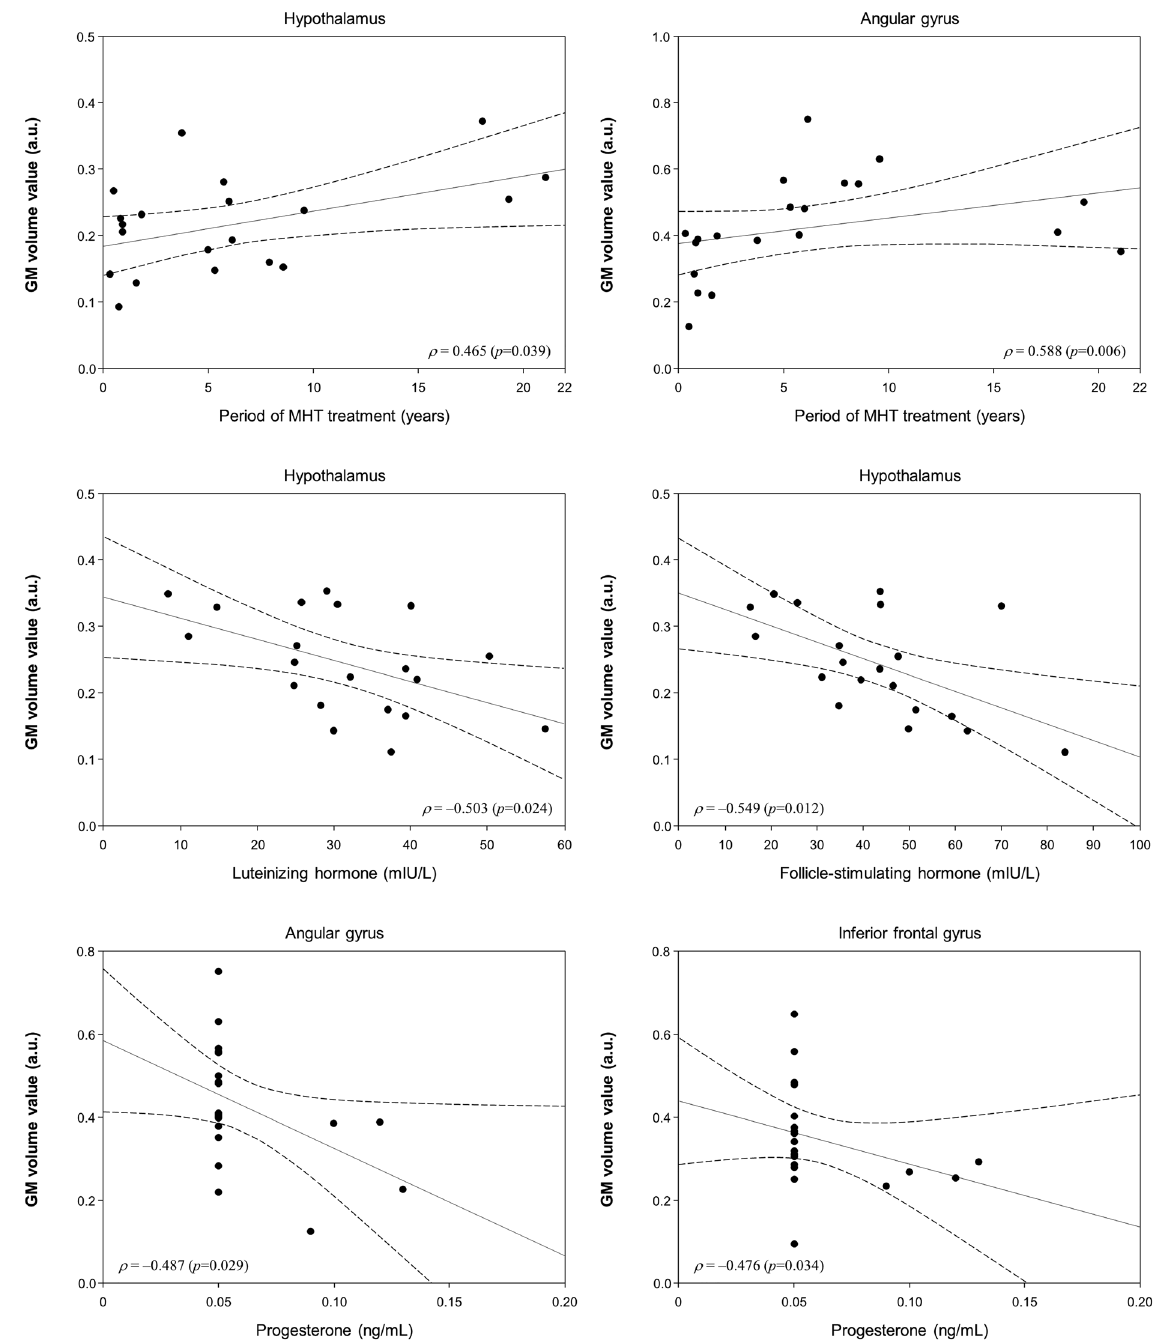
Figure 3. The period of MHT treatment in women was positively correlated with mean gray matter (GM) volume value in the hypothalamus and angular gyrus. Follicle-stimulating hormone (FSH), luteinizing hormone (LH) and progesterone (PG) levels in MHT women were negatively correlated with GM volume value in the hypothalamus, angular gyrus, and inferior frontal gyrus. Note that the y-axis scales (GM volume value) are different each other. Dotted lines show 95% confidence interval (CI). a.u. = arbitrary